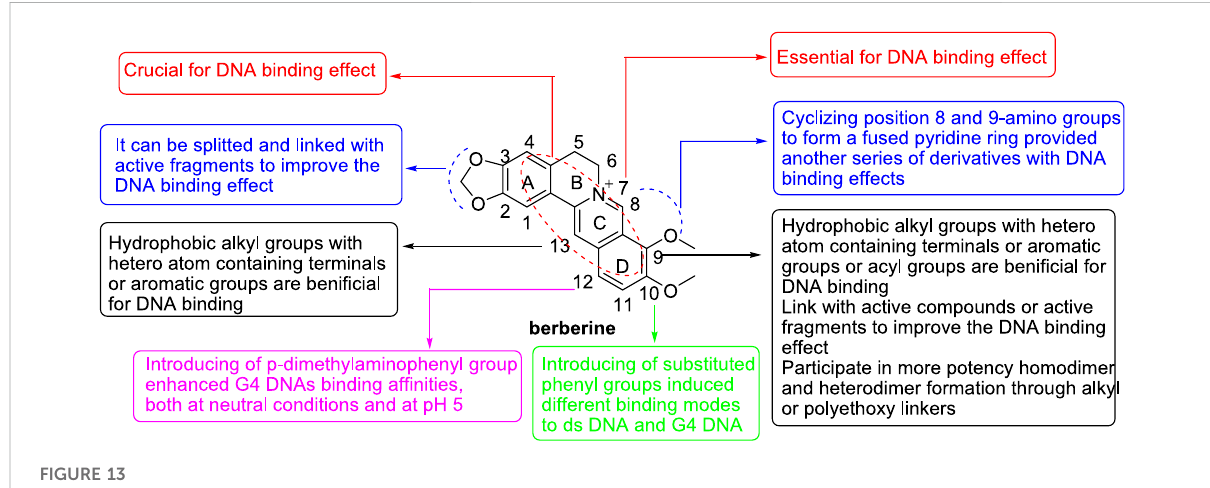
FIGURE 13 SAR of BBR derivatives towards ds DNA and G4 DNA.